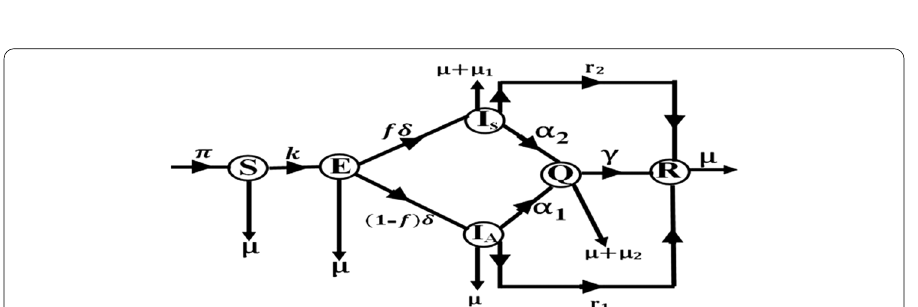
Fig. 2 The schematic representation of transmission of COVID-19 infections in Plateau State, Nigeria. k =